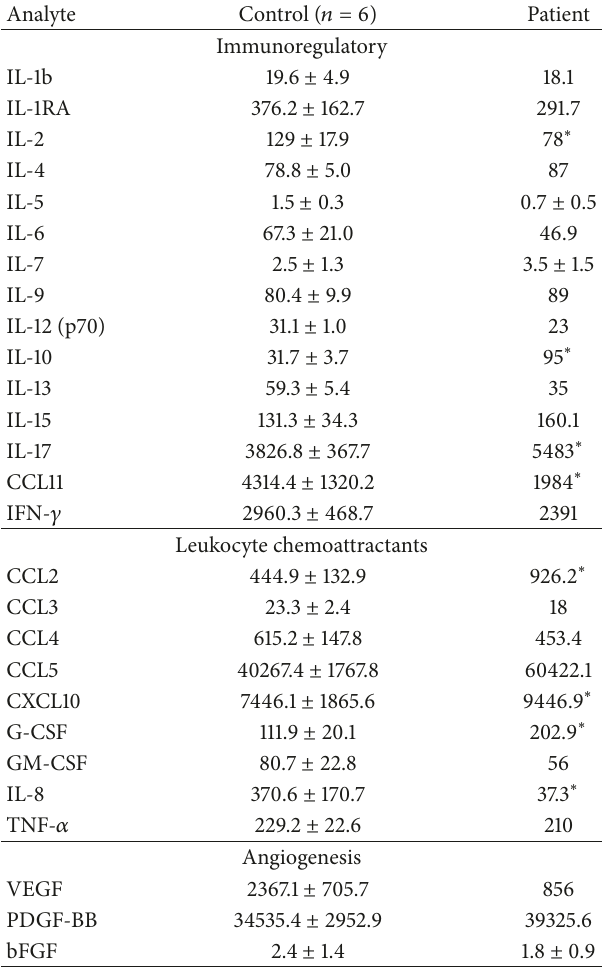
Table 2: Analysis of patient and controls cytokine